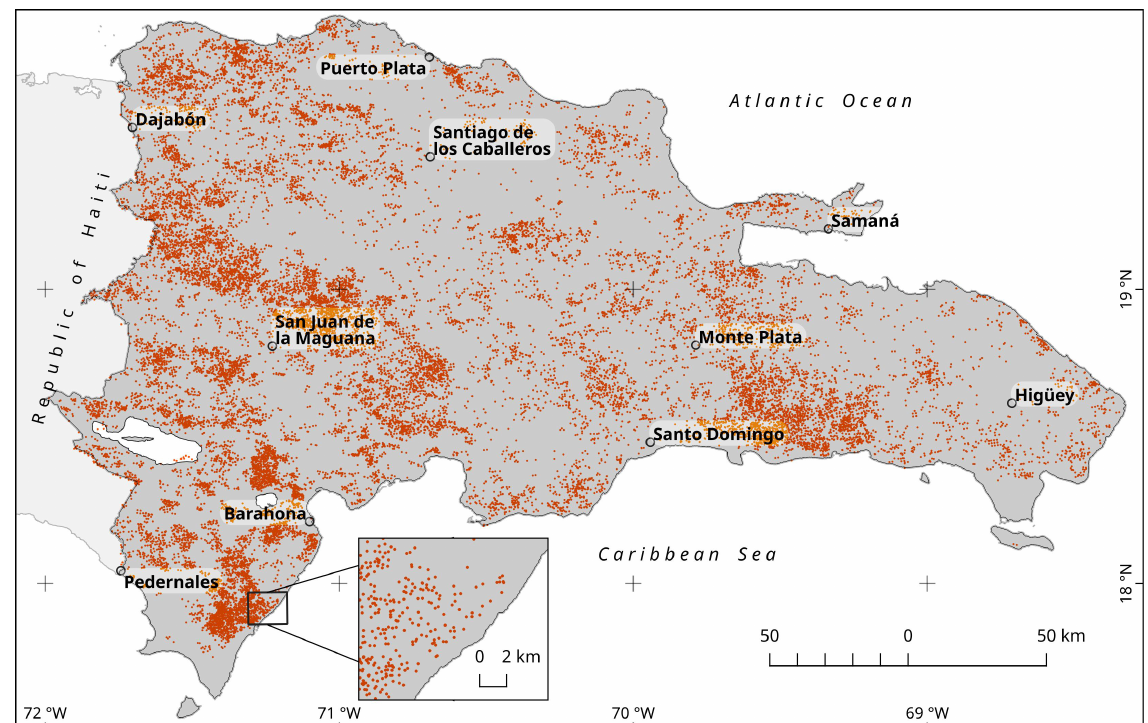
Figure S1 – MODIS fire points/hotspots from 2001 to 2018 for the DR mainland. This is a noise-free version of the original dataset, which excludes unrelated fire points (e.g., burning landfills and industrial furnaces). See text for details.